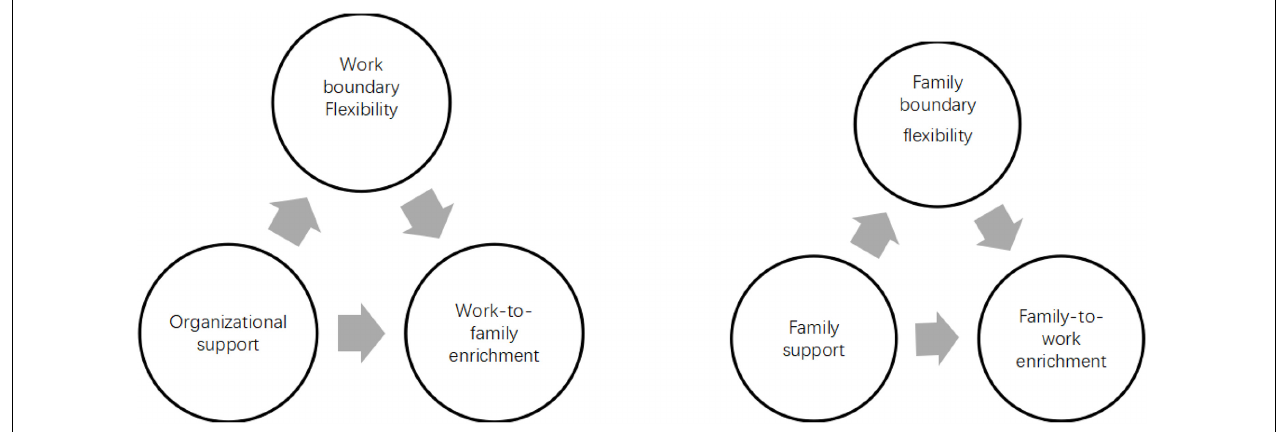
FIGURE 1 | Research